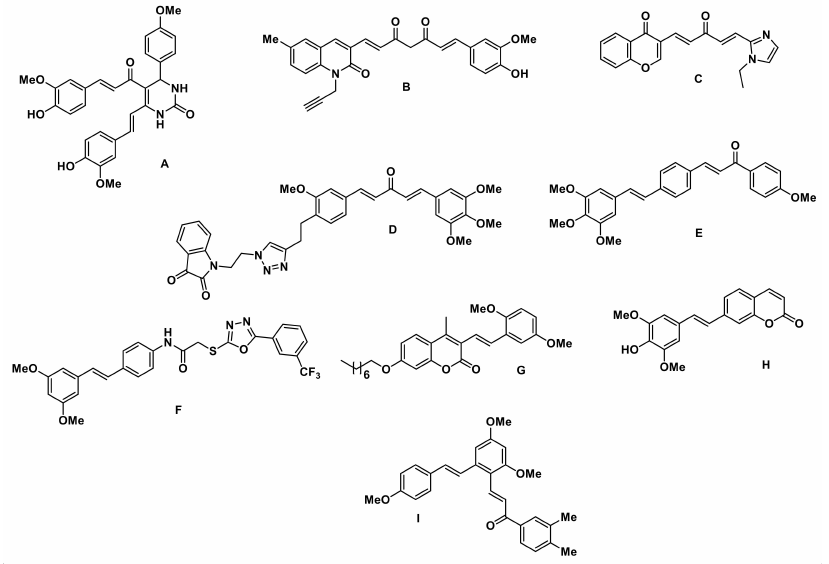
Figure 1. Hybrid molecules derived from curcumin and resveratrol with anticancer